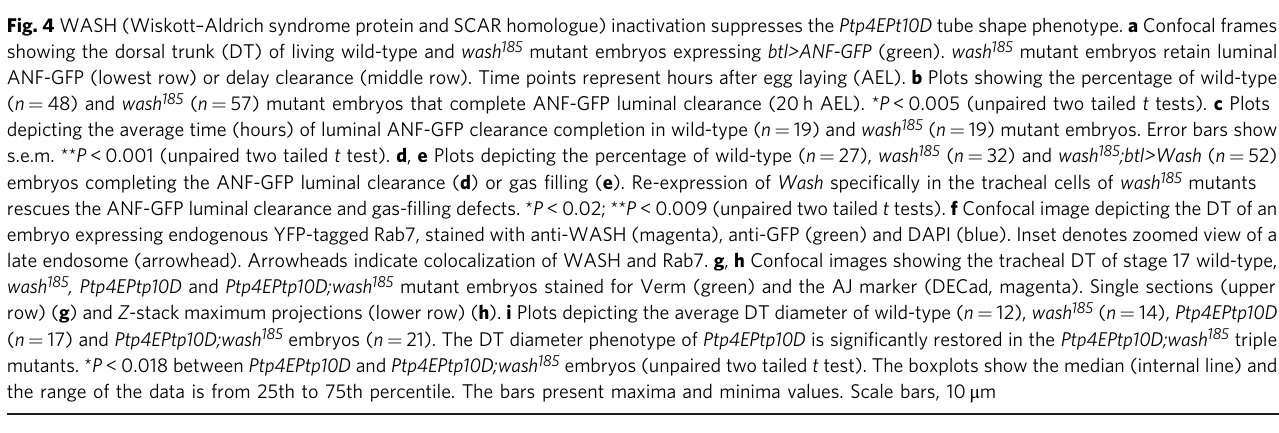
Fig. 4 WASH (Wiskott – Aldrich syndrome protein and SCAR homologue) inactivation suppresses the Ptp4EPt10D tube shape phenotype. a Confocal frames showing the dorsal trunk (DT) of living wild-type and wash 185 mutant embryos expressing btl>ANF-GFP (green). wash 185 mutant embryos retain luminal ANF-GFP (lowest row) or delay clearance (middle row). Time points represent hours after egg laying (AEL). b Plots showing the percentage of wild-type ( n = 48) and wash 185 ( n = 57) mutant embryos that complete ANF-GFP luminal clearance (20 h AEL). * P < 0.005 (unpaired two tailed t tests). c Plots depicting the average time (hours) of luminal ANF-GFP clearance completion in wild-type ( n = 19) and wash 185 ( n = 19) mutant embryos. Error bars show s.e.m. ** P < 0.001 (unpaired two tailed t test). d , e Plots depicting the percentage of wild-type ( n = 27), wash 185 ( n = 32) and wash 185 ;btl>Wash ( n = 52) embryos completing the ANF-GFP luminal clearance ( d ) or gas fi lling ( e ). Re-expression of Wash speci fi cally in the tracheal cells of wash 185 mutants rescues the ANF-GFP luminal clearance and gas- fi lling defects. * P < 0.02; ** P < 0.009 (unpaired two tailed t tests). f Confocal image depicting the DT of an embryo expressing endogenous YFP-tagged Rab7, stained with anti-WASH (magenta), anti-GFP (green) and DAPI (blue). Inset denotes zoomed view of a late endosome (arrowhead). Arrowheads indicate colocalization of WASH and Rab7. g , h Confocal images showing the tracheal DT of stage 17 wild-type, wash 185 , Ptp4EPtp10D and Ptp4EPtp10D;wash 185 mutant embryos stained for Verm (green) and the AJ marker (DECad, magenta). Single sections (upper row) ( g ) and Z -stack maximum projections (lower row) ( h ). i Plots depicting the average DT diameter of wild-type ( n = 12), wash 185 ( n = 14),